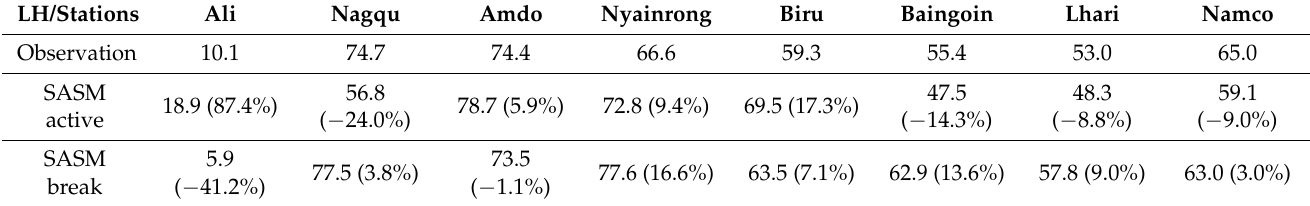
Table 3. Latent heat flux (LH) (Wm − 2 ) over the 8 plateau stations, averaged for the observations and SASM active and break periods. The bracketed values denote the LH increasing (decreasing) percent- age of the daily averaged value, in which the positive (negative) values mean increasing